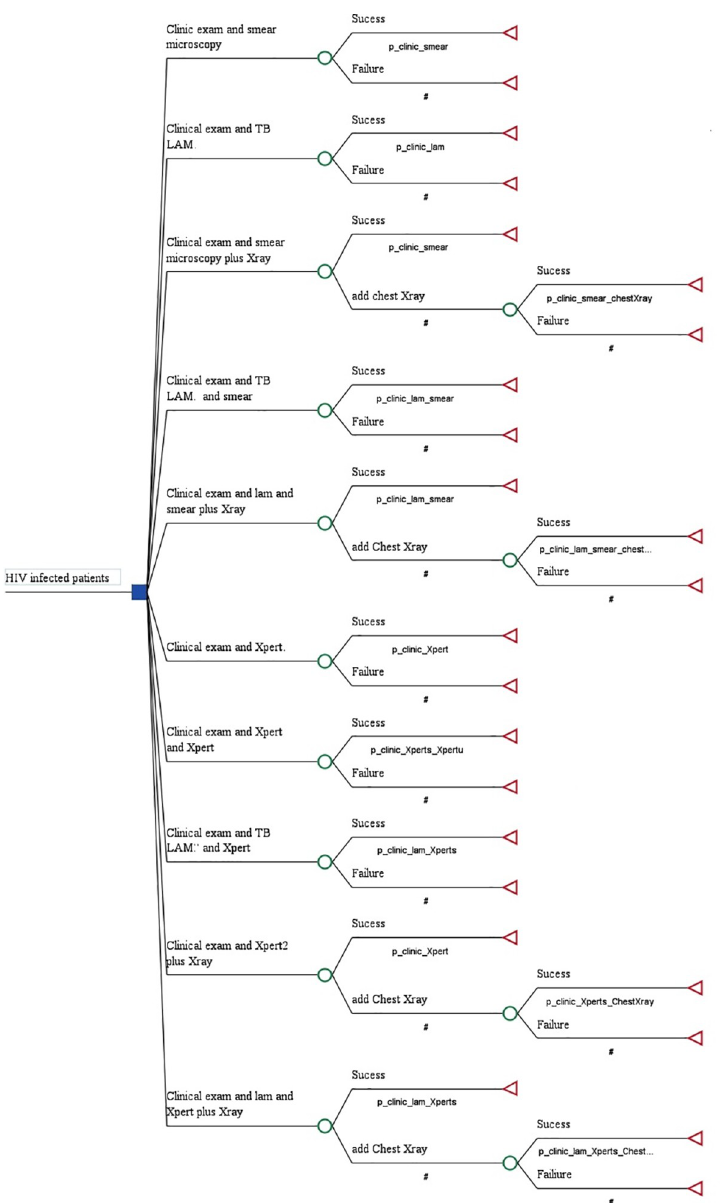
Fig 1. Diagnostic algorithms using microscopy or GeneXpert alone or in combination with chest X-ray versus LF-LAM alone or in addition to other TB diagnostic tools.